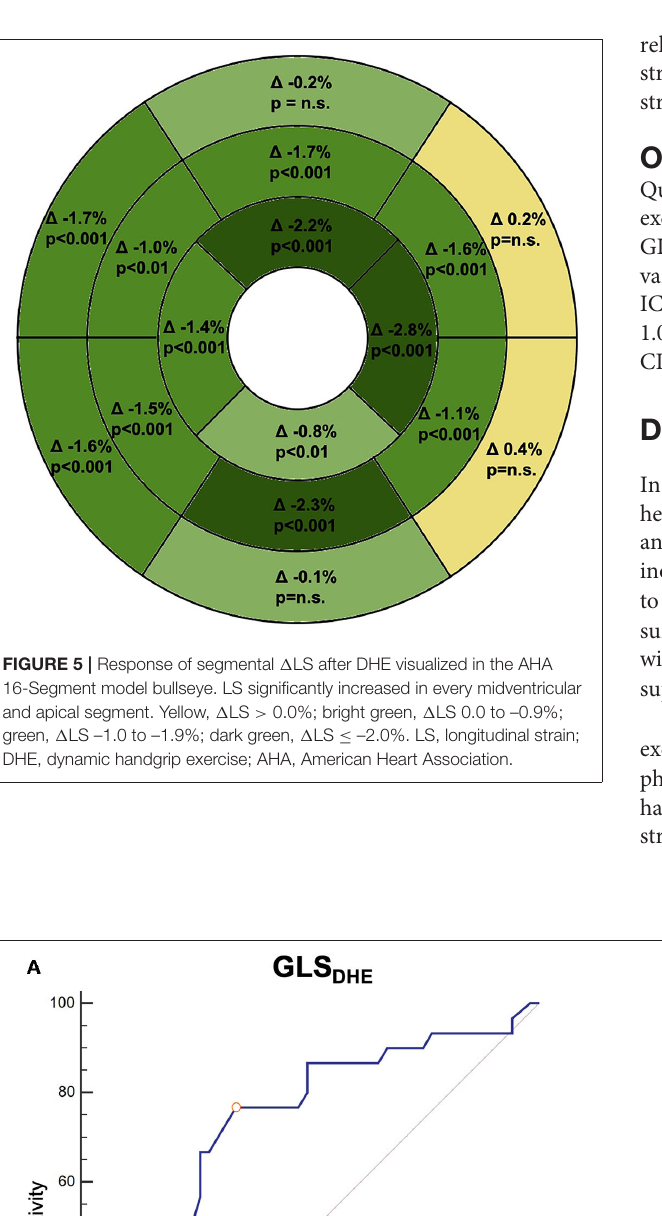
Frontiers in Cardiovascular Medicine |